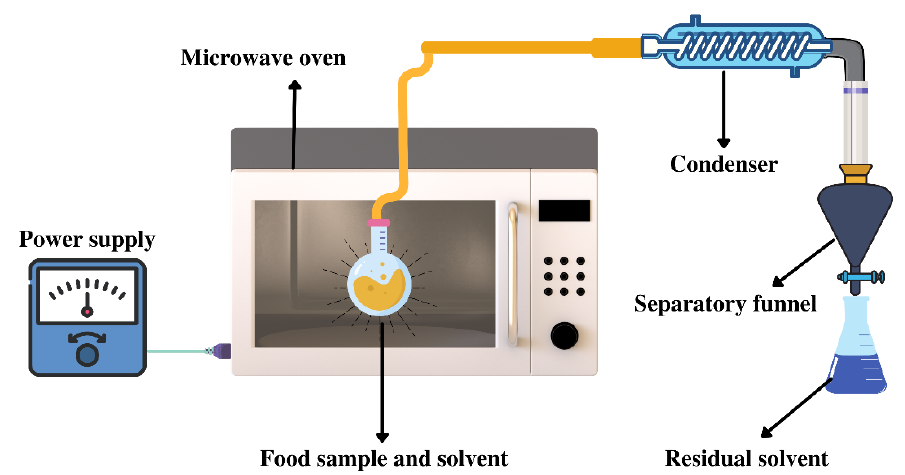
Figure 5. Simplified schematic of MAE with the help of a condenser.